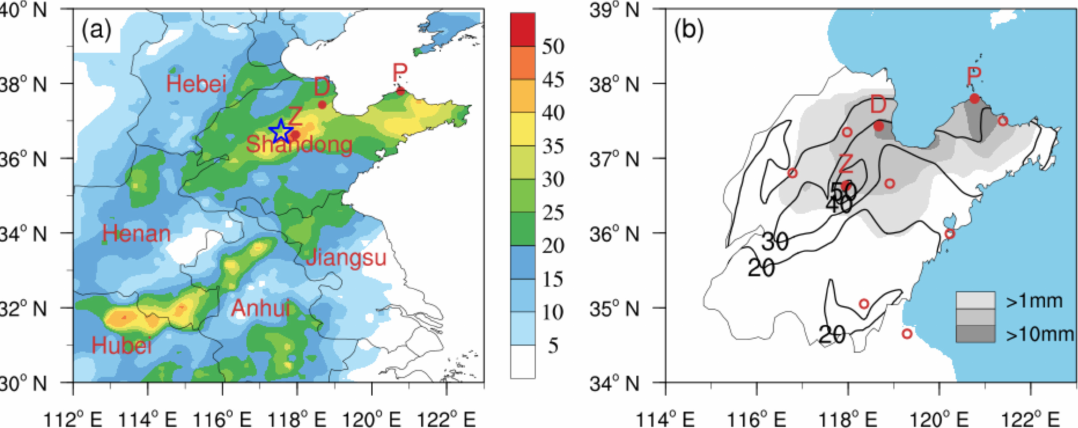
Figure 2. Rain gauge observed ( a ) precipitation and ( b ) snowfall (unit: mm) from 1200 UTC 12 to 1200 UTC 13 February 2016. The locations of Shandong, Anhui, Jiangsu, Hebei, Hubei, and Henan Provinces are labeled in ( a ). The letters “Z”, “D”, and “P” denote the cities of Zichuan, Dongying, and Penglai, respectively. The blue star in ( a ) indicate Zhangqiu sounding station. Red open circles in ( b ) denote the locations of Doppler radars used in radar